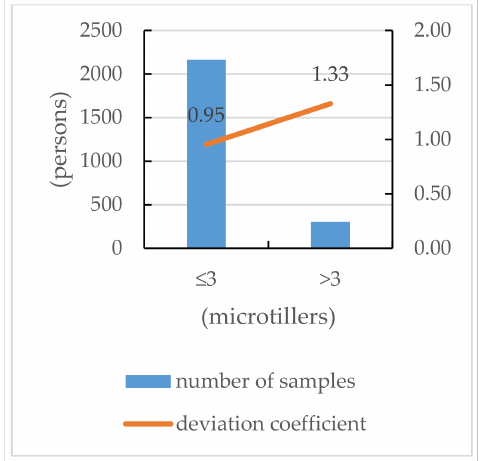
Figure 11. Deviation coefficient of agricultural machinery utilization rate grouped by numbers of microtillers.